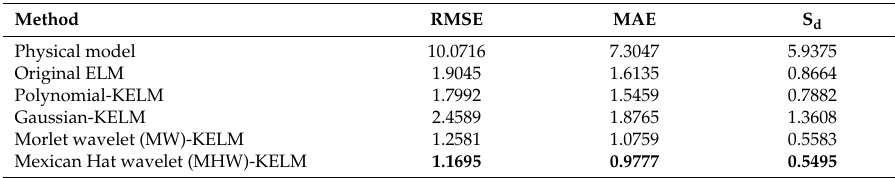
Table 3. Results of Sinc testing data set.